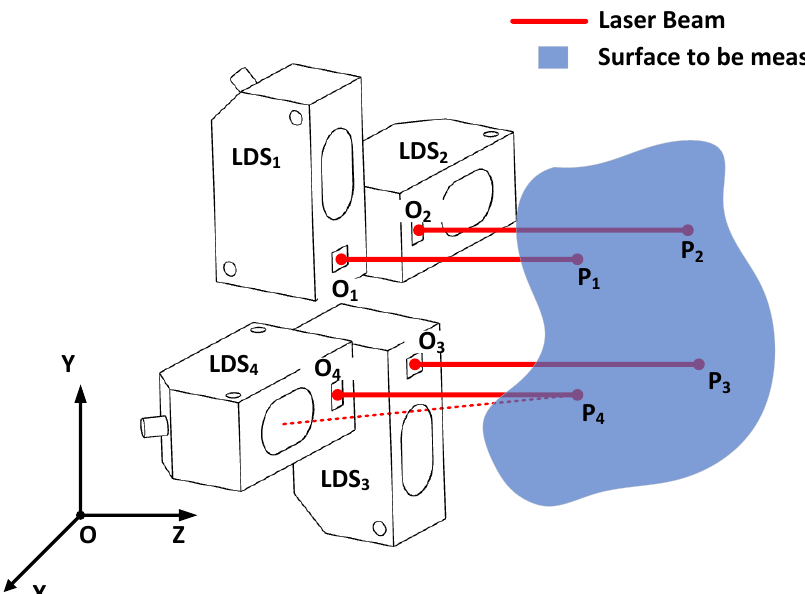
Figure 1. A sketch of the surface normal measurement